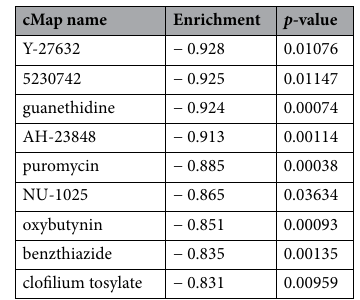
Table 2. The candidate small molecules with highly significant correlations in the results of